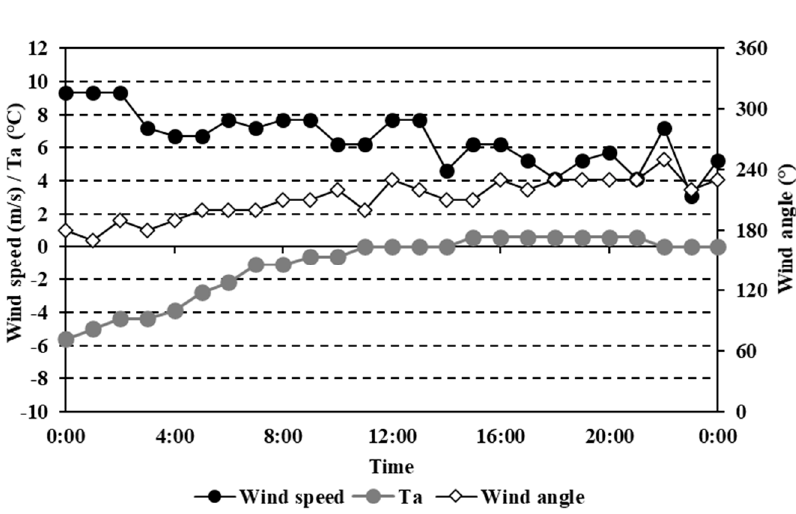
Figure 3. Outdoor atmospheric parameters for CONTAM simulations (Chicago, 21 December). Ta is the air temperature.